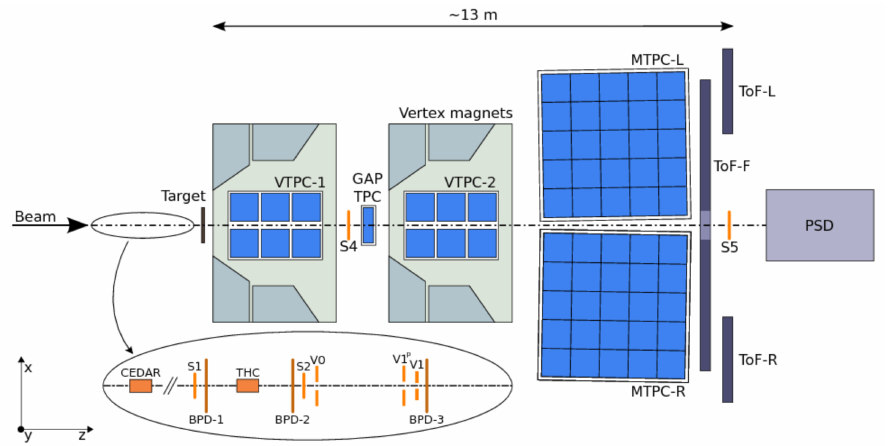
Figure 11. Layout of the NA61/SHINE experiment